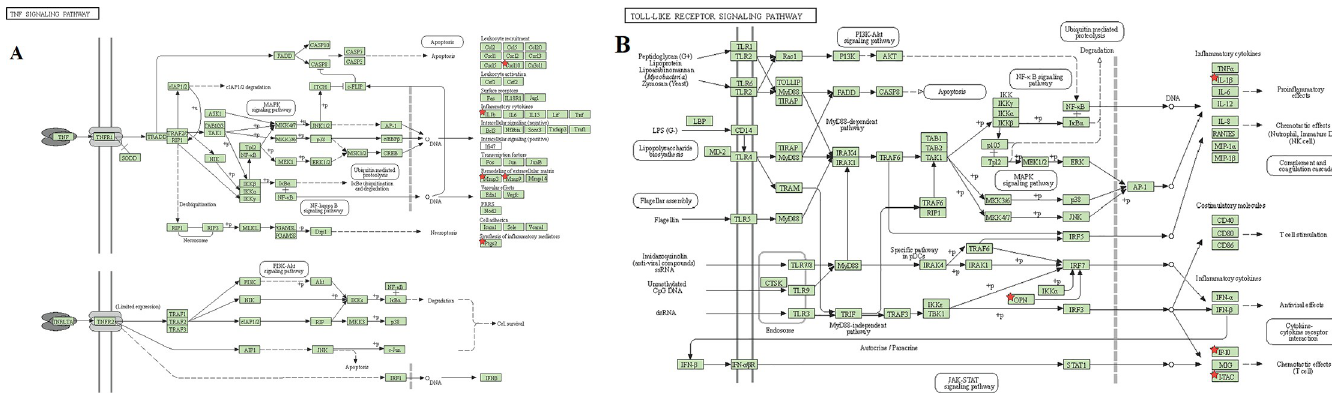
Fig 10. KEGG enrichment diagram. (A) TNF signaling pathway. (B) Toll-like receptor signaling pathway. Red asterisks represent core targets.